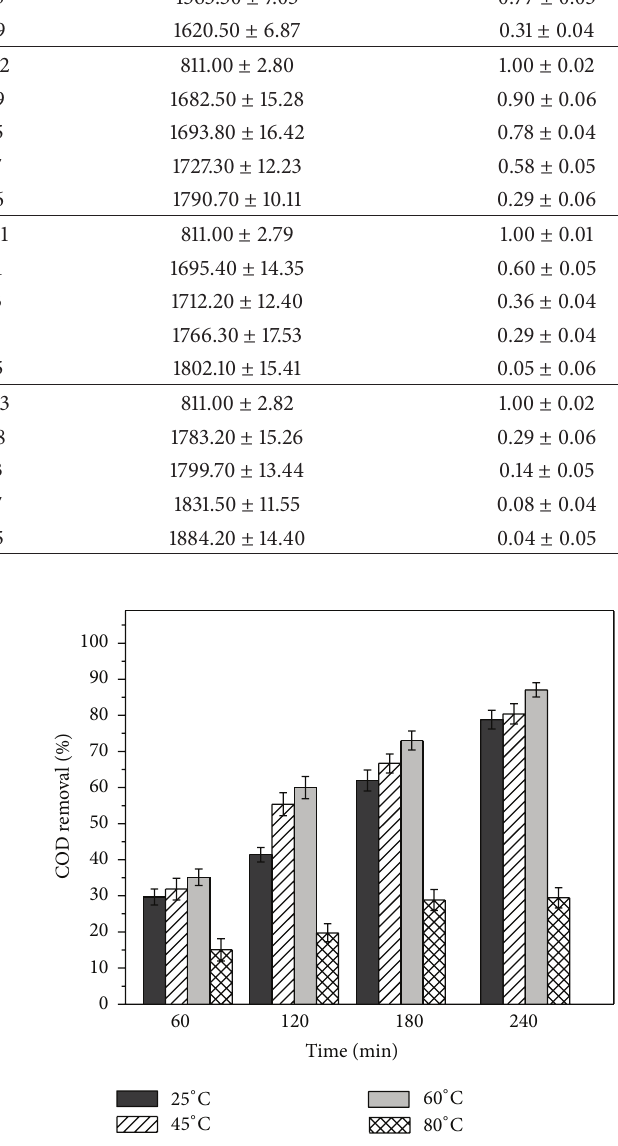
Figure 9: Effect of temperature on COD removal. Experimental conditions: UV/1% H 2 O 2 and initial pH of